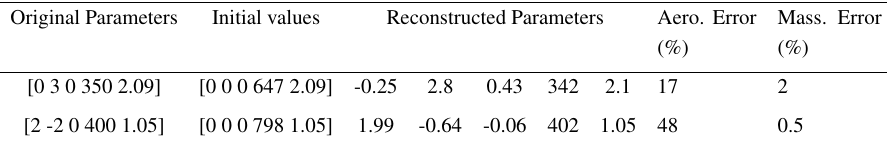
Table 2 . Test results with Tikhonov’s regularization and fminsearch .